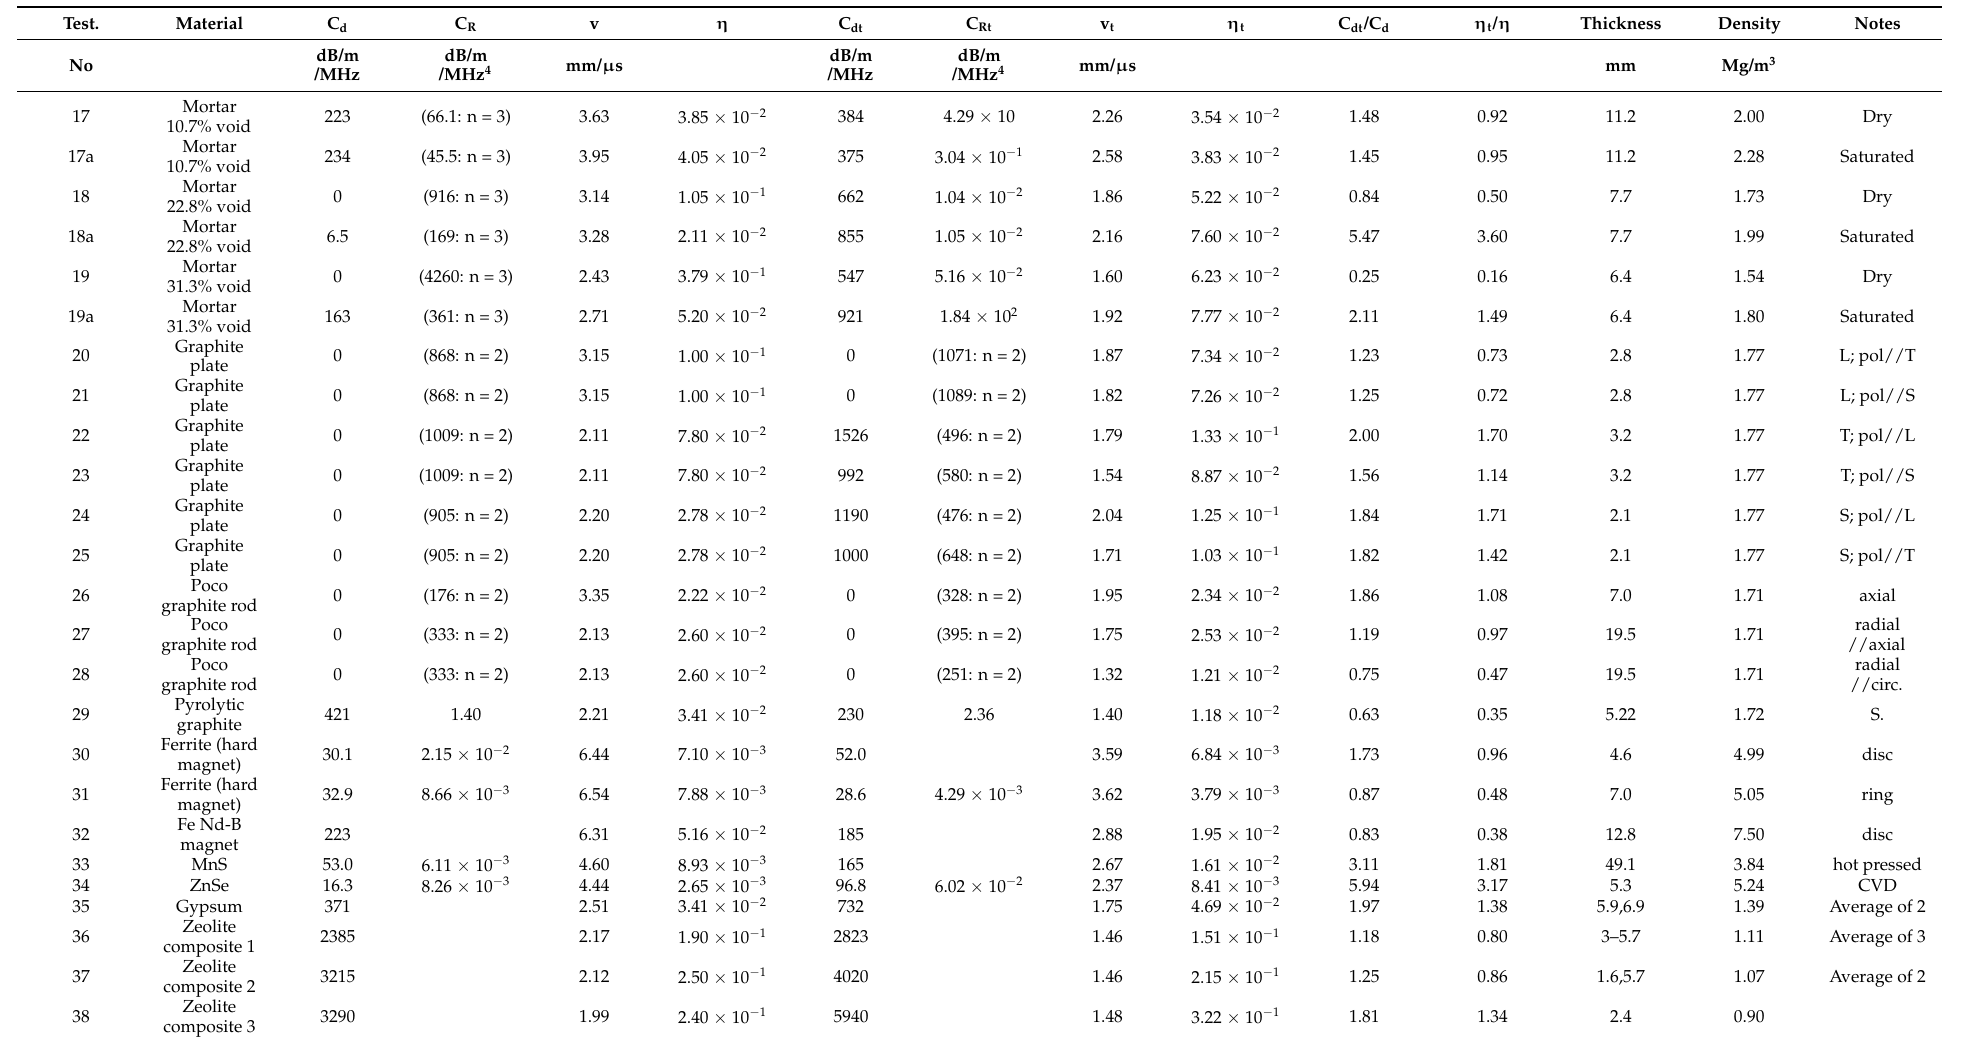
Table 6. Attenuation coefficients of longitudinal and transverse modes of other ceramics, mortars and